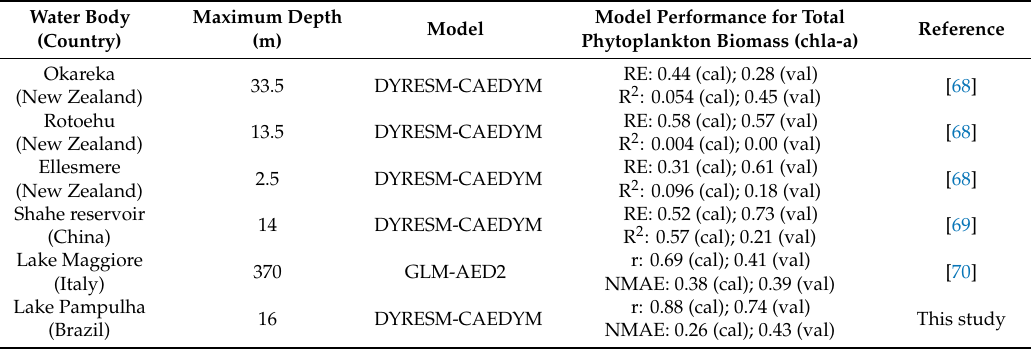
Table 7. Model performance for phytoplankton biomass simulation. NMAE is the normalized mean absolute error, r is the correlation coe ffi cient, RE is the mean relative error, R 2 is the determination coe ffi cient. Cal: calibration period; val: validation